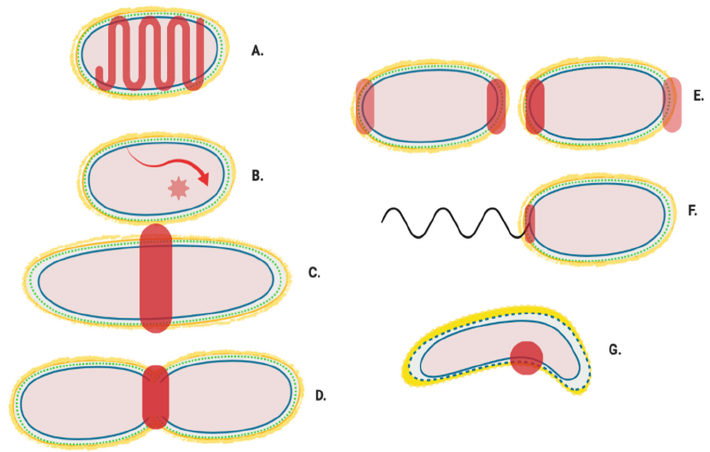
Figure 2. Generalised localisation of peptidoglycan modifying proteins. Localisation regions of known and potential peptidoglycan modifying enzymes in Gram-negative bacteria. Localisation sites are highlighted in red. ( A ) Helical and MreB associated Elongasome; ( B ) Free diffusion (unlocalised) [11]; ( C ) Pre-septal machinery; ( D ) Division machinery; ( E ) Post septal polar machinery and polar growth [13–15]; ( F ) Flagella peptidoglycan modification machinery [16], and ( G ) Shape determining pinpoint/seam[17,18].